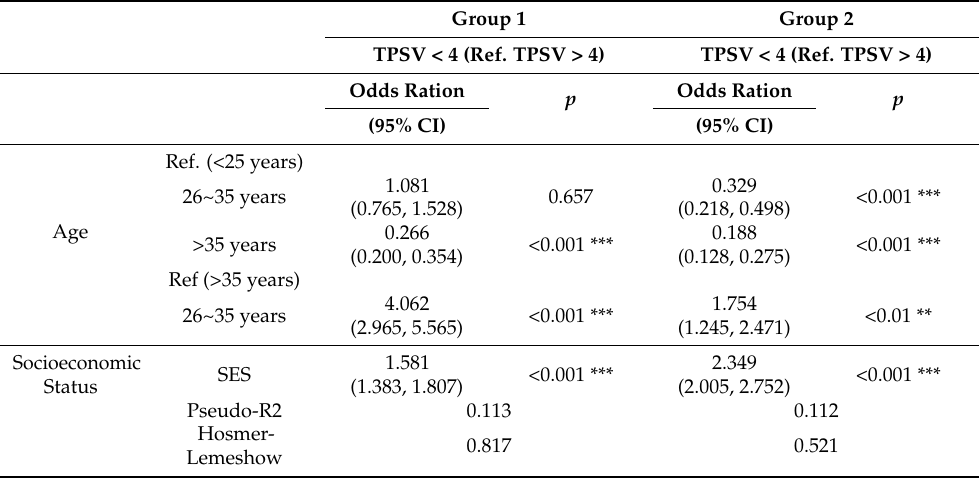
Table 6. Dominance ratios and 95% confidence intervals for binary logistic LR stepwise regression analysis of the relationship between demographic variables and TPSV (Note: *** p ≤ 0.001, ** p ≤